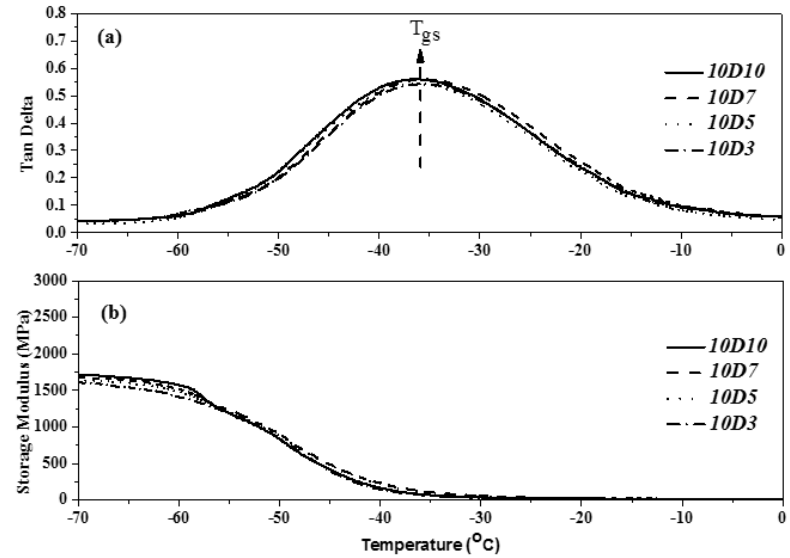
Figure 17. DMA curve of TPU with end-capping agent at concentration of 10 phm, (Effect of temperature on ( a ) Tan Delta ( b ) the storage modulus of TPU).